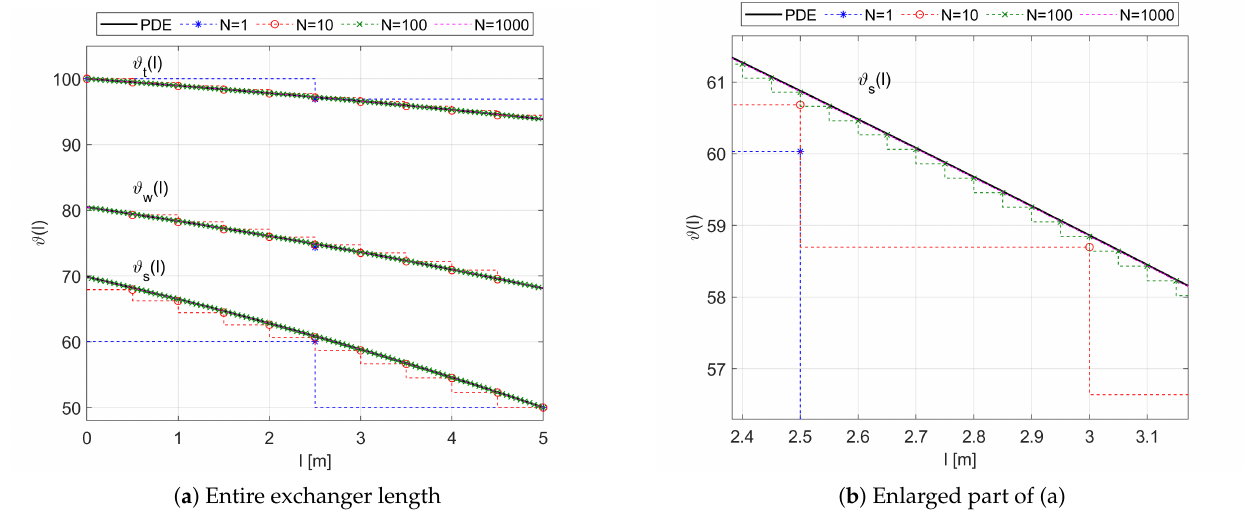
Figure 6. Steady-state responses ¯ ϑ ( l ) of the irrational transfer function model of the double-pipe counter-flow heat exchanger vs. steady-state responses ¯ˆ ϑ ( l n ) of its approximate rational transfer function models for different N . Fluid inlet temperatures: ¯ ϑ ti = 100 ○ C, ¯ ϑ si = 50 ○